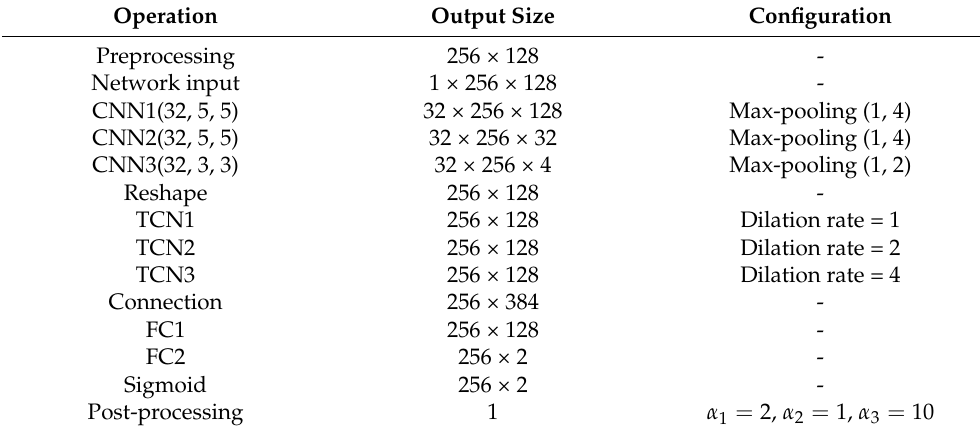
Table 2. The main parameters of the proposed method.